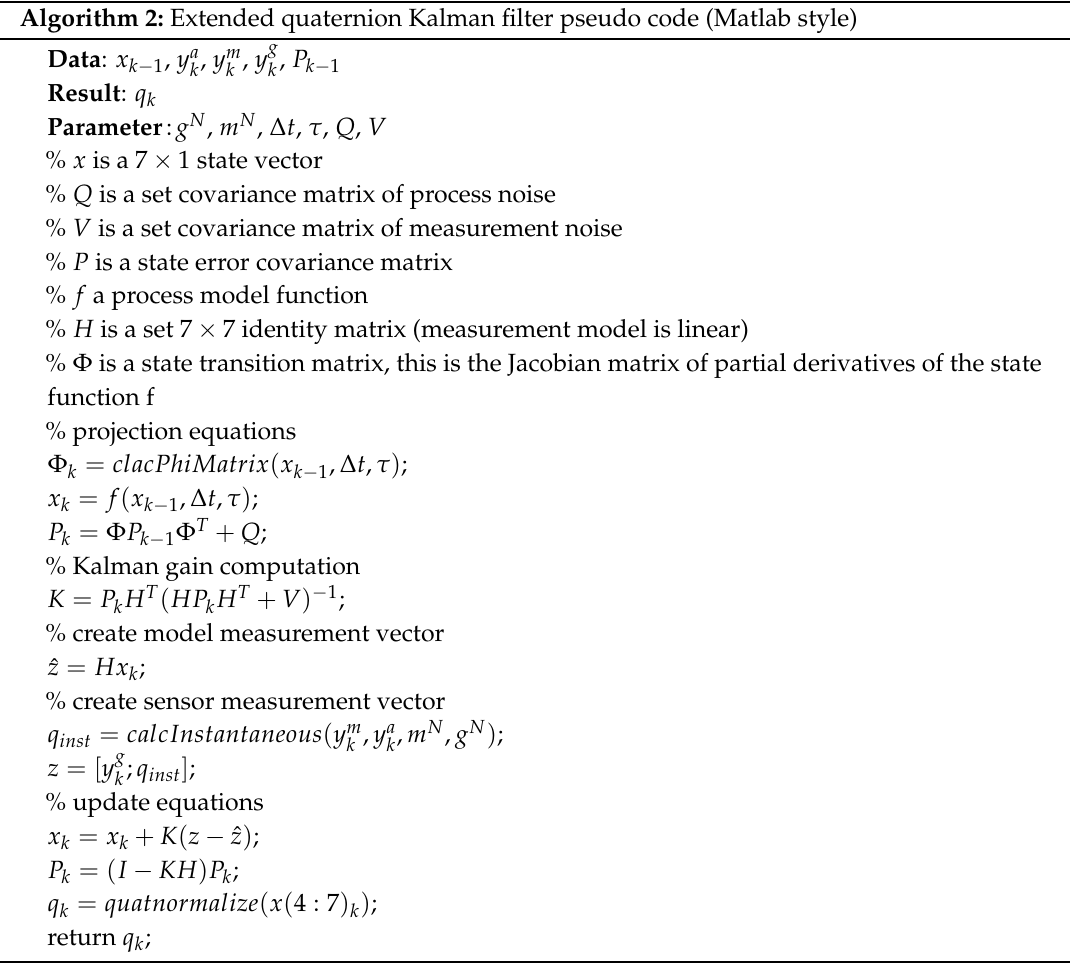
Figure 6. The EQKF flow chart. Algorithm 2: Extended quaternion Kalman filter pseudo code (Matlab